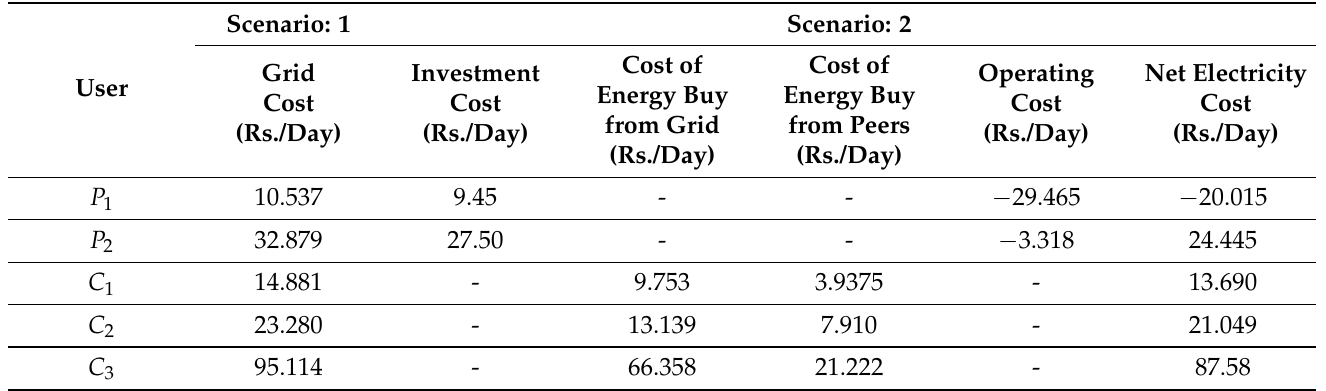
Table 7. One day total electricity cost (Rs.) of prosumer and